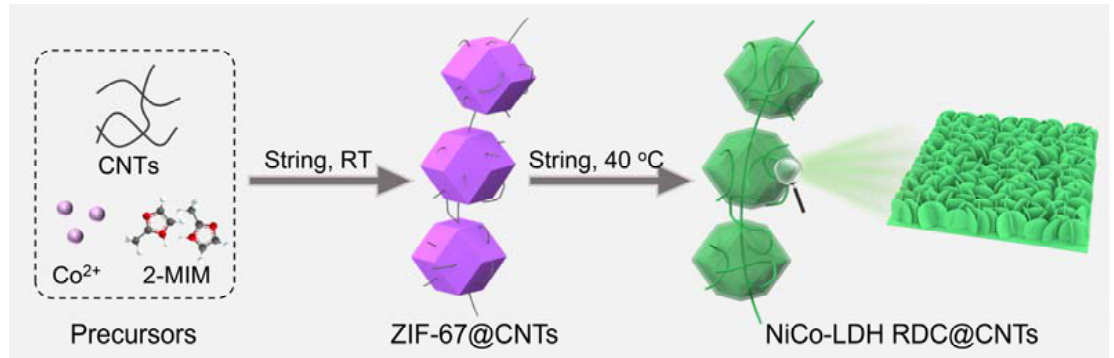
Figure 1. Schematic illustration for the synthesis of NiCo ‐ LDH RDC@CNTs.